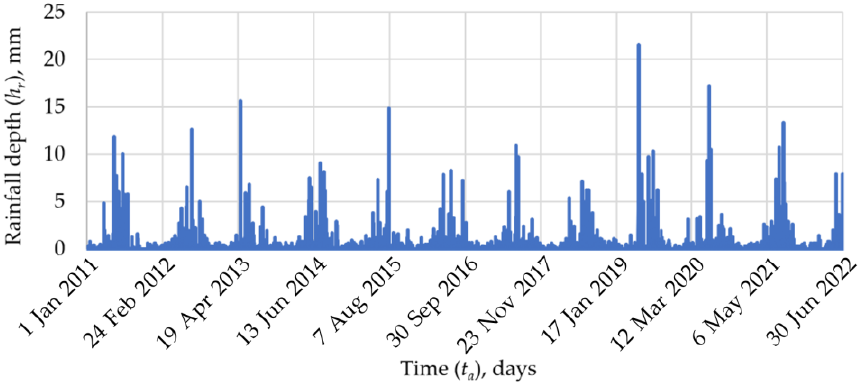
Figure 9. Rainfall depth at the KOLBUSZOWA 250210220 meteorological station with a 10 min time step (based on [62]).